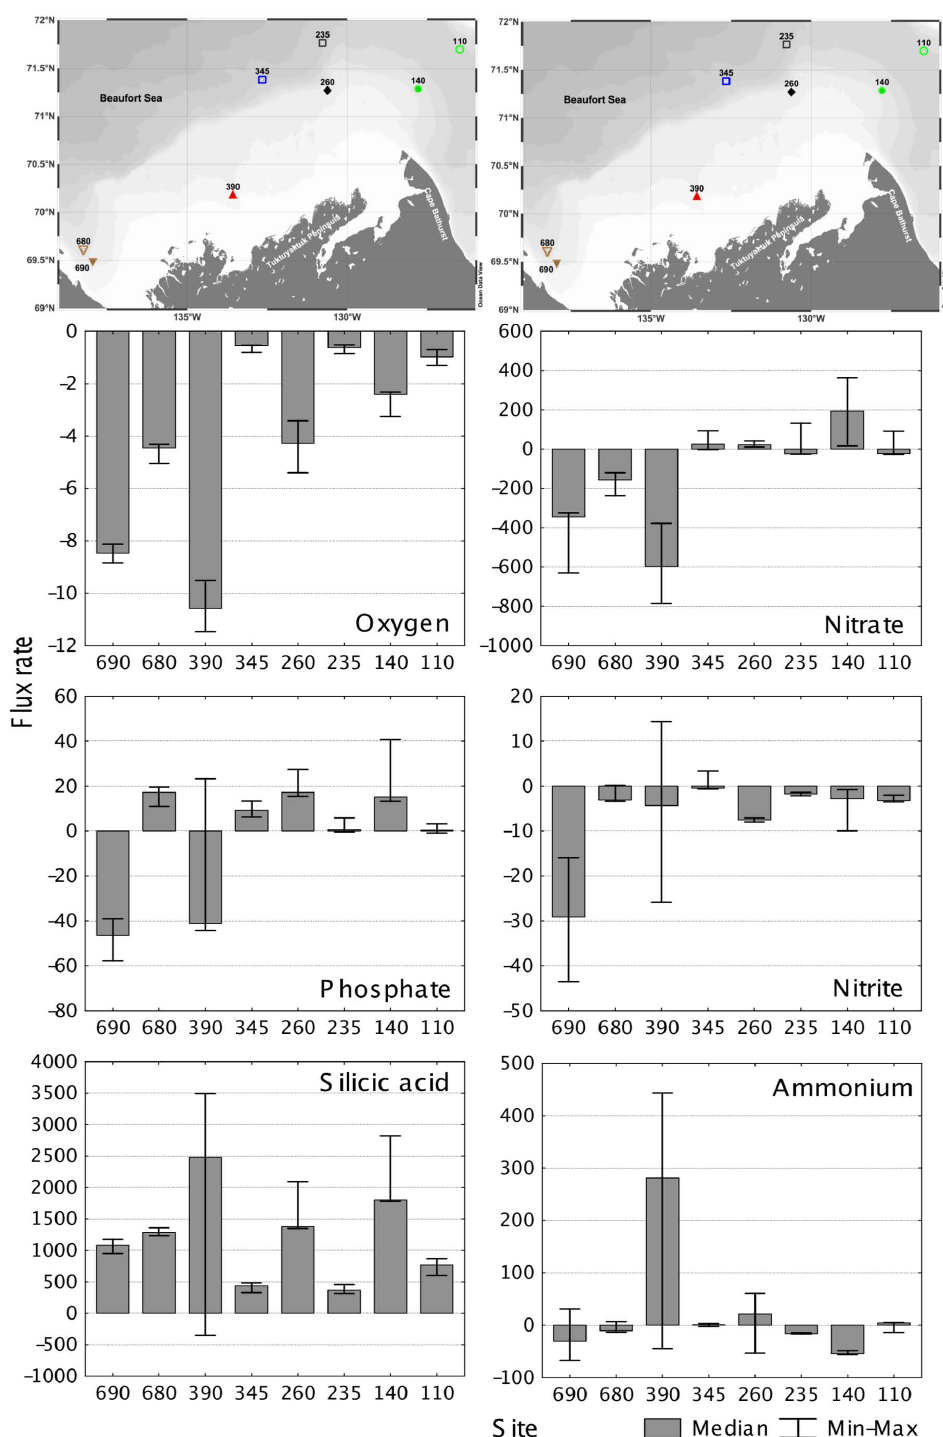
Fig. 2. Benthic boundary fluxes in the southeastern Beaufort Sea in relation to their location. Flux rates are presented in mmolm − 2 d − 1 for oxygen and in µmolm − 2 d − 1 for all other fluxes. The values of three replicates (median, minimum and maximum) from each site are shown along the y-axis. Positive values indicate release from sediments, negative values uptake by sediments; the deviation level is a reference to the zero plane. See Table 2 for exact